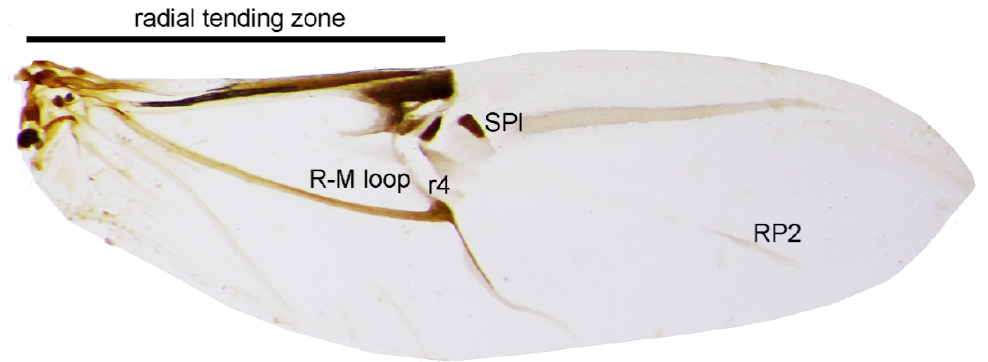
Figure 2. Spiculum ventrale (female eighth sternite) of Acentrus histrio . “Arch”-like arms ( a ), apodeme ( b ). (Not to scale). Figure 3. Hind wing of Acentrus histrio. Lateral sclerotized plate (SPl), radio-medial loop (R–M loop), radius posterior 2 (RP2), r4 vein (r4). (Not to scale).